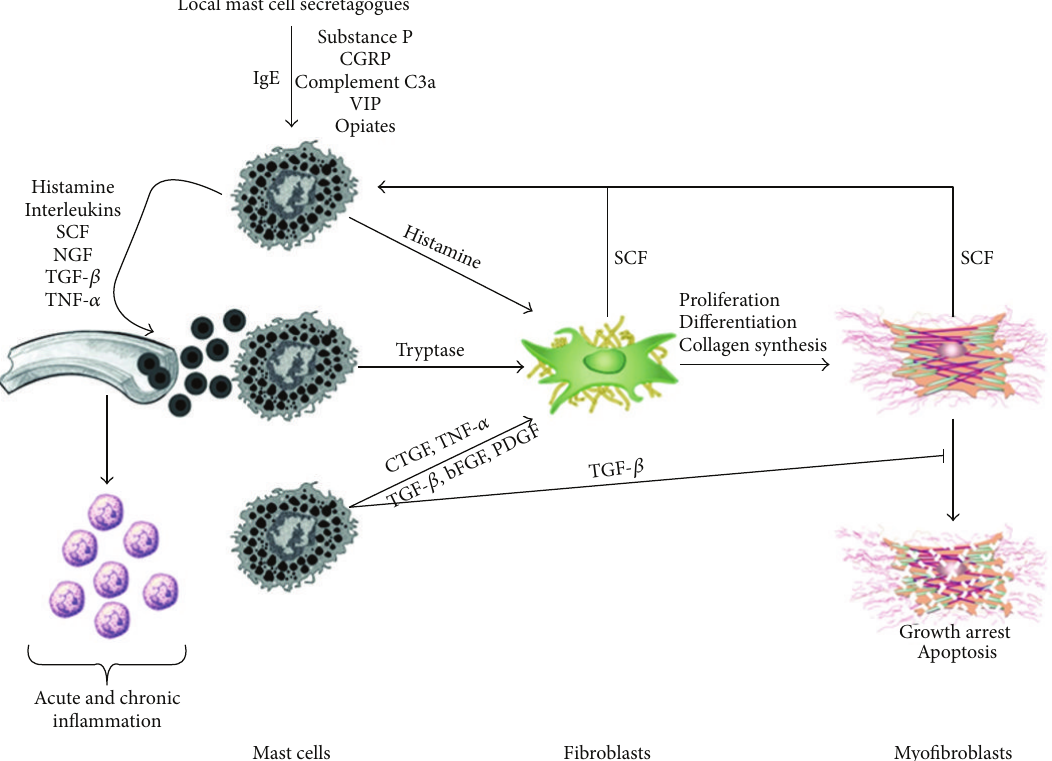
Figure 1: Mast cells mediated inflammation and fibrosis. Mast cells circulate as CD34-positive precursor cells and terminally differentiate in connective tissues. Both IgE dependent and independent mechanisms can activate mast cells causing the release of preformed and newly synthesized proinflammatory mediators. Many of these mediators increase vascular permeability and promote the recruitment of other inflammatory cells and additional mast cell precursors. SCF is also secreted by activated fibroblasts and myofibroblasts, further potentiating mast cell recruitment and proliferation. TGF- 𝛽 is a potent fibroblast mitogen and stimulator of myofibroblast differentiation. It also impedes myofibroblasts apoptosis. bFGF, basic fibroblast growth factor; CGRP, calcitonin gene-related peptide; CTGF, connective tissue growth factor; NGF, nerve growth factor; PDGF, platelet-derived growth factor; SCF, stem cell factor; TGF- 𝛽 , transforming growth factor-beta; TNF- 𝛼 , tumor necrosis factor-alpha; VIP, vasoactive intestinal peptide. This figure was reproduced from